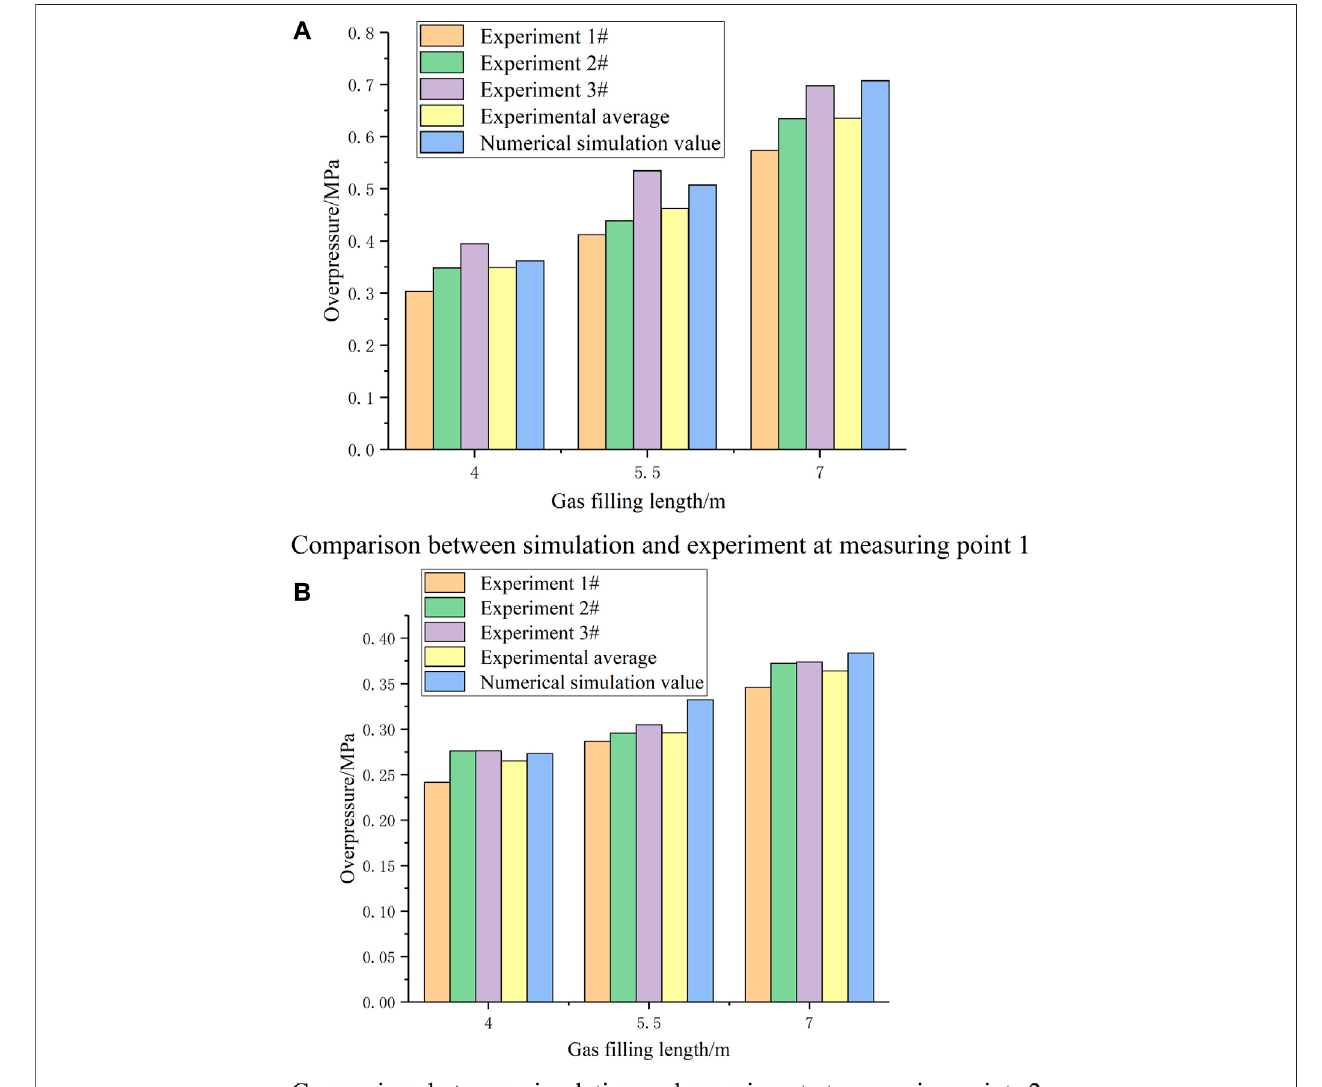
FIGURE4| Comparisonbetweensimulationandexperimentatdifferentgas fi llinglengths. (A) Comparisonbetweensimulationandexperimentatmeasuringpoint 1. (B) Comparison between simulation and experiment at measuring point 2.